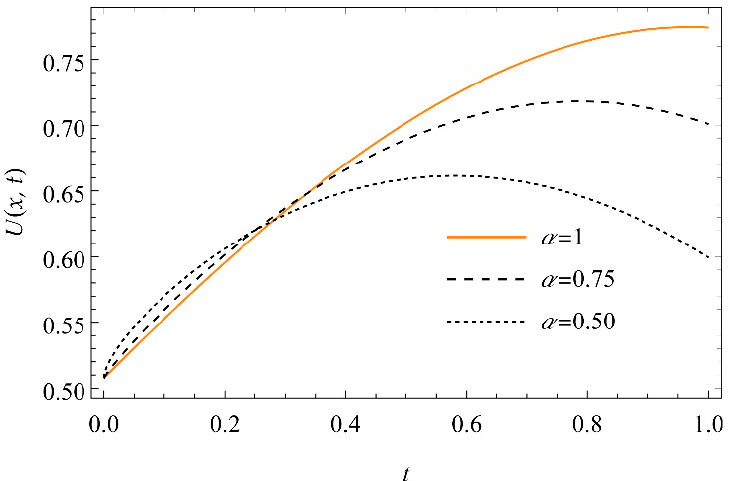
Figure 12. The graph of 𝑈(𝑥, 𝑡) versus time 𝑡 at 𝑛 = 1, 𝑥 = 0.5 , and for 𝛼 = 1, 0.75, 0.50 for